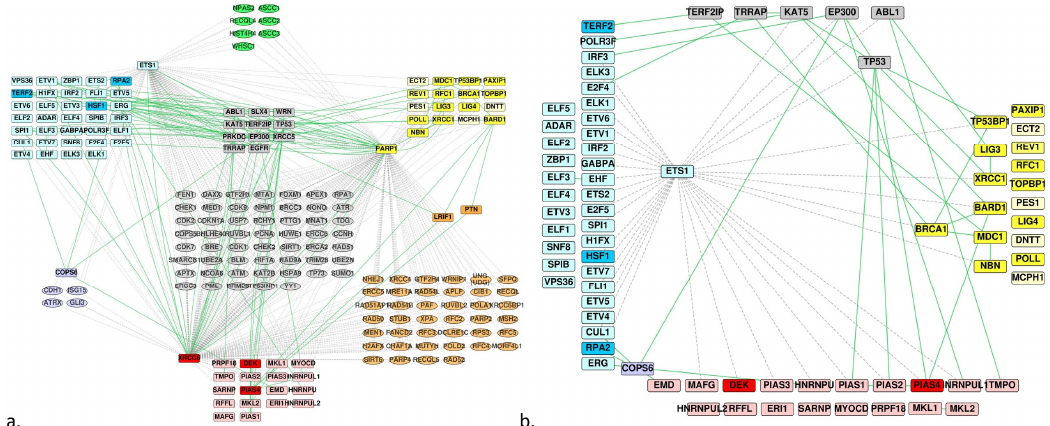
Figure 4. PPI network filtered on proteins involved in DNA repair mechanisms. ( a ) The same network